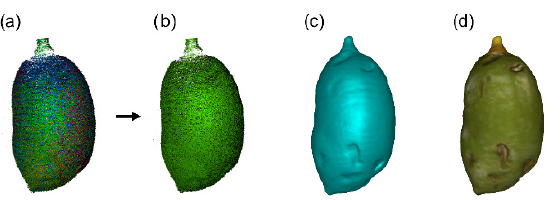
Figure 4. 3D scanning process: ( a ) partial scans; ( b ) scans registering; ( c ) 3D mesh generation, and ( d ) 3D mesh texturing. Table 3. Example of results obtained from scanning